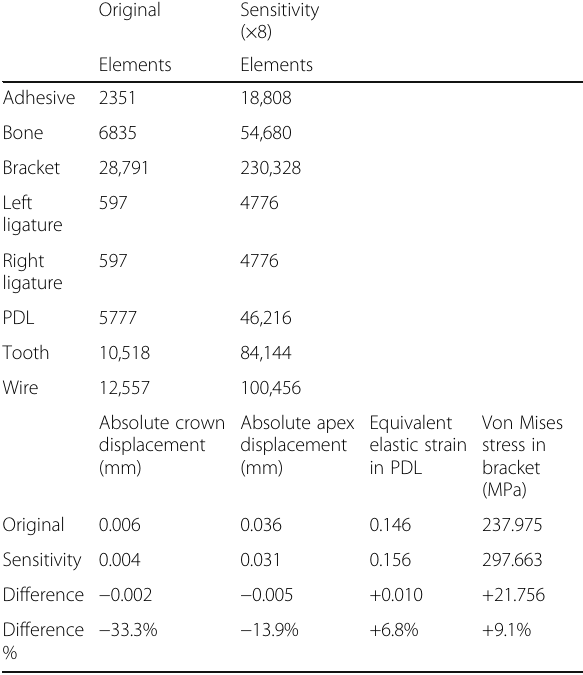
Table 4 Sensitivity analysis by octupling the total number